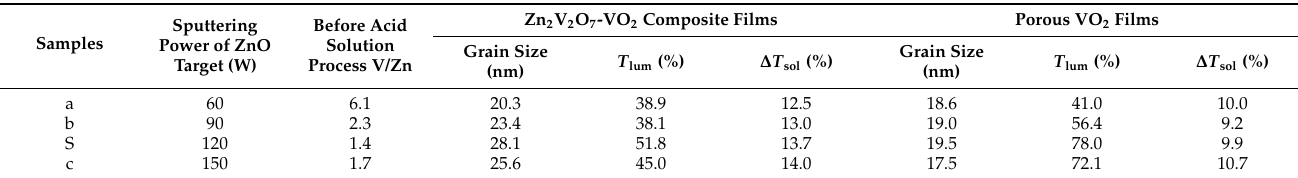
Table 2. Optical properties and grain size of Zn 2 V 2 O 7 -VO 2 composite films (before acid solution processing) and porous VO 2 films (after acid solution processing) with different sputtering power of ZnO target. Samples